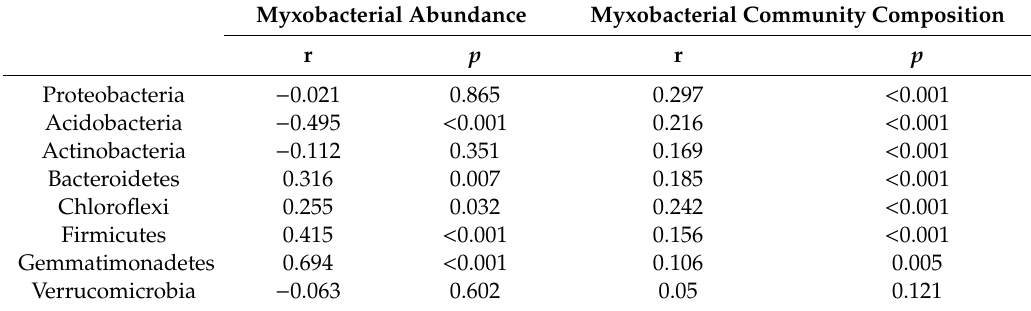
Table 1. Correlations between myxobacteria and soil bacterial groups at the phylum level of subtropical and tropical forest soil. The relationship between soil bacteria and myxobacterial abundance was indicated by Spearman coefficient, and the correlation between bacterial abundance and myxobacterial community (pairwise Bray-Curtis distance) was indicated by Spearman correlation using the Mantel test.